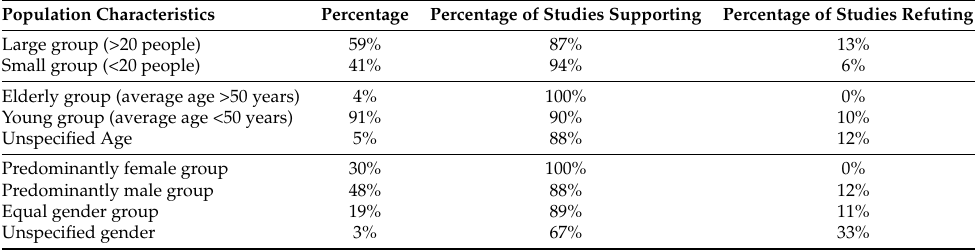
Table 5. Characteristics of the study